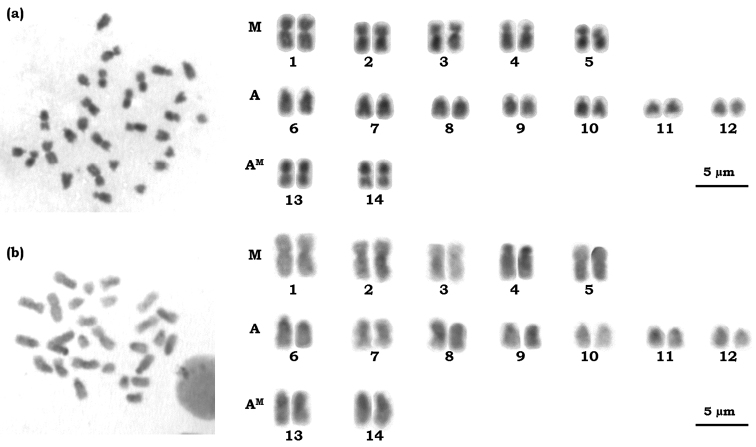
 Karyotype of female workers of Azteca trigona 2n = 28 sorted according to the classification proposed by Imai (1991)
a Conventional staining using Giemsa b C-banding showing the distribution of heterochromatin.